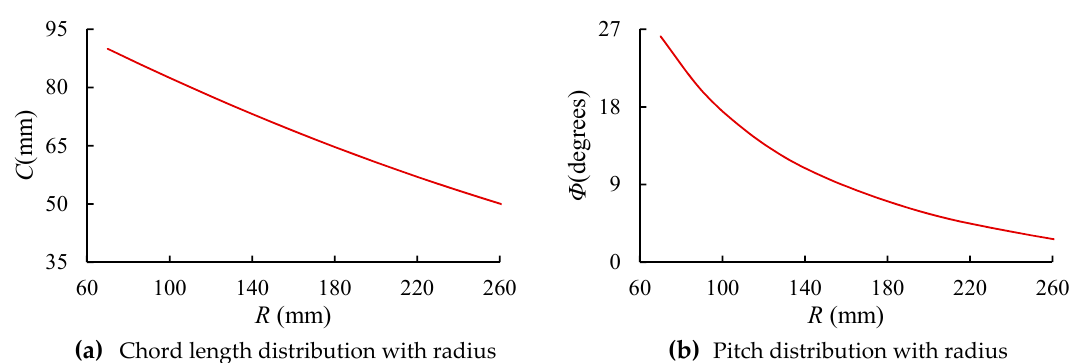
Figure 1. Chord length and pitch distribution with radius.